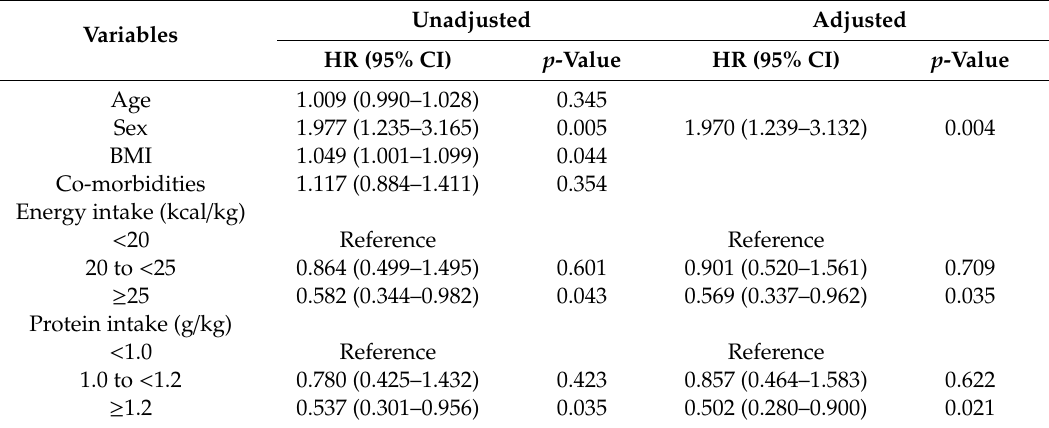
Table 5. Cox regression analysis for 28-day mortality in high nutritional risk